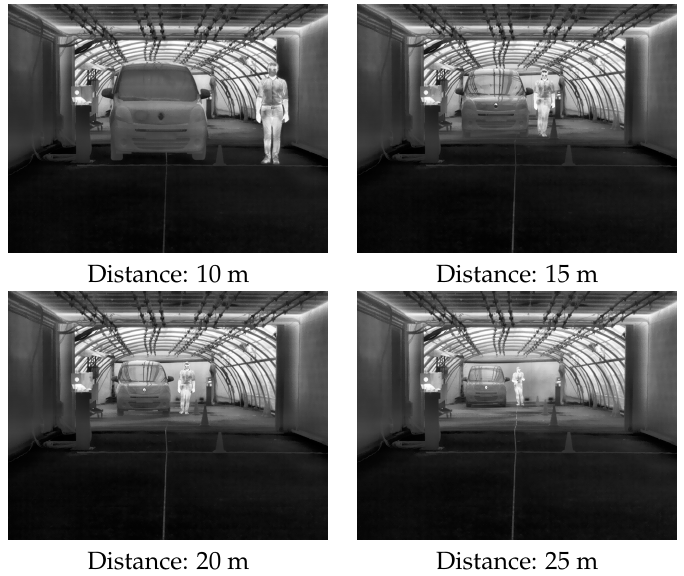
Figure 11. Four different camera-to-target distances used during dynamic scenarios.